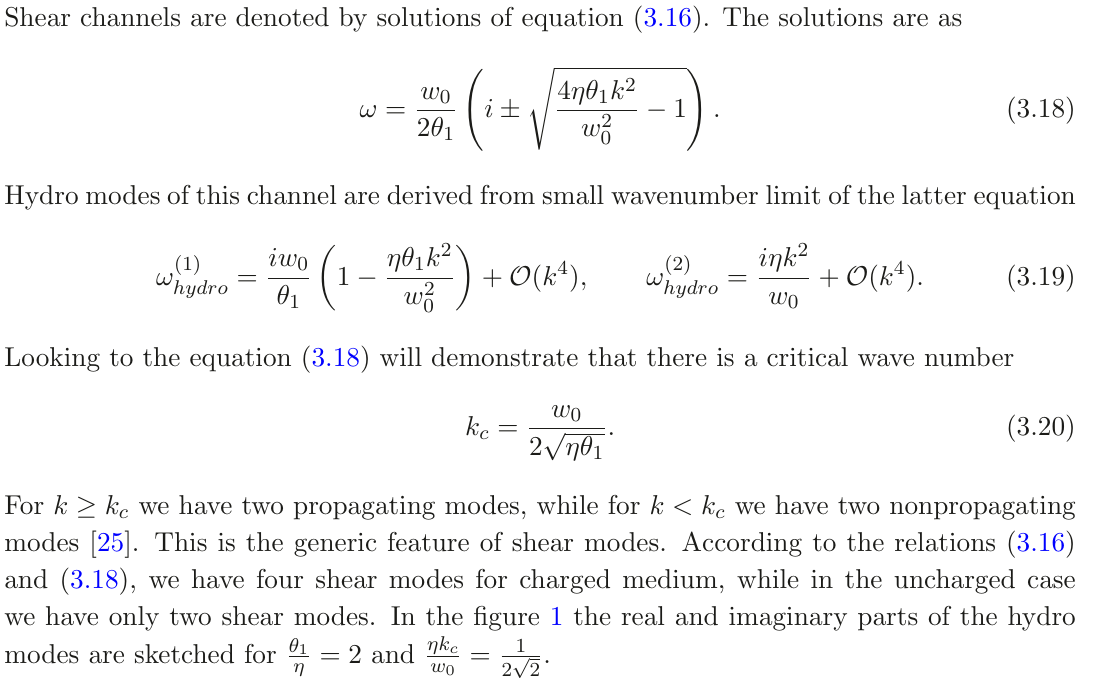
Figure 1 . Real and imaginary parts of hydro modes in the shear channel for θ 1 corresponds to the real part and right figure corresponds to the imaginary part of shear modes. The blue and red curves represent two branches of solutions in the relation